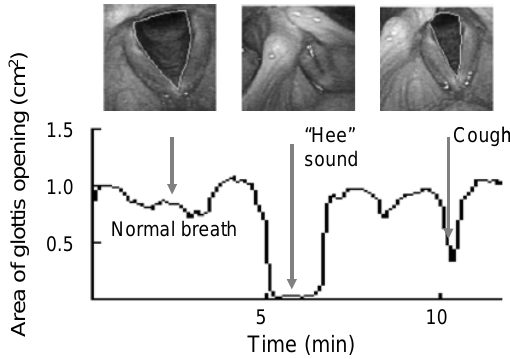
Fig. 4. Opening and narrowing of the glottis aperture with di®erent breathing maneuvers. Upper panel from left to right: representative image of the glottis during either normal breathing, \Hee"-sound making, or coughing, respectively. The edge of the opening glottis aperture was marked by the white line. Lower panel: Time course of the area of glottis opening quanti¯ed by the image-based method during the same breathing maneuvers.